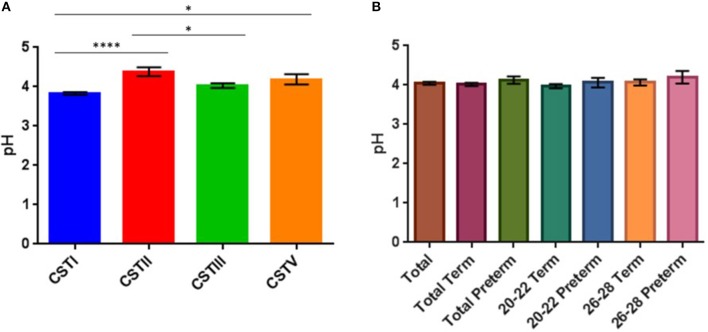
(A) Bar plots showing CST in relation to mean vaginal pH (with SEM), (*P < 0.05, ****P < 0.0001). (B) Vaginal pH of total and sub-cohort (no significant differences).